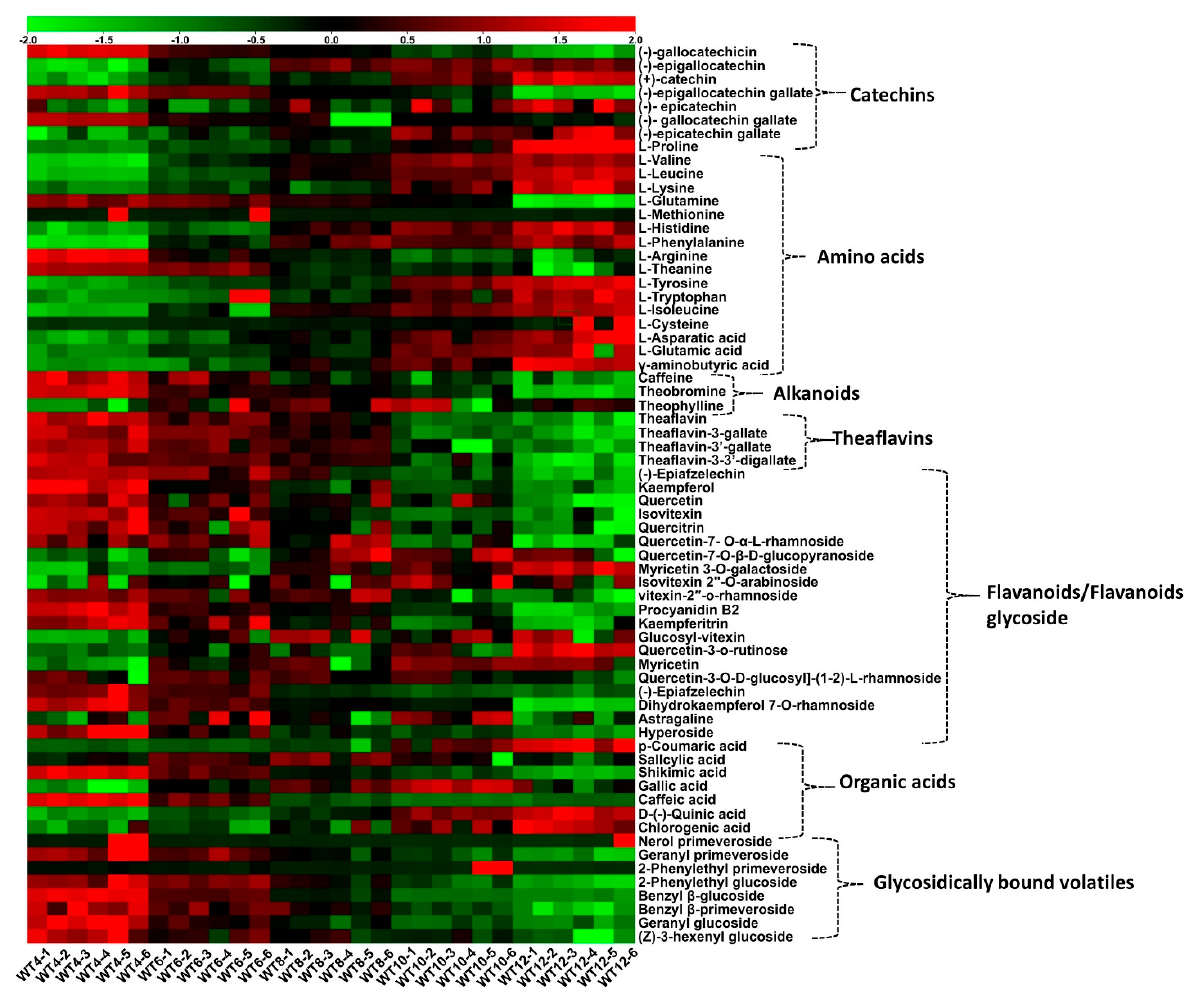
Figure 1. The variations in nonvolatile compounds of black tea under different withering times were visualized using a heatmap. The increase in the relative content of the compounds is represented by a transition from green to black to red, as shown in the legend.